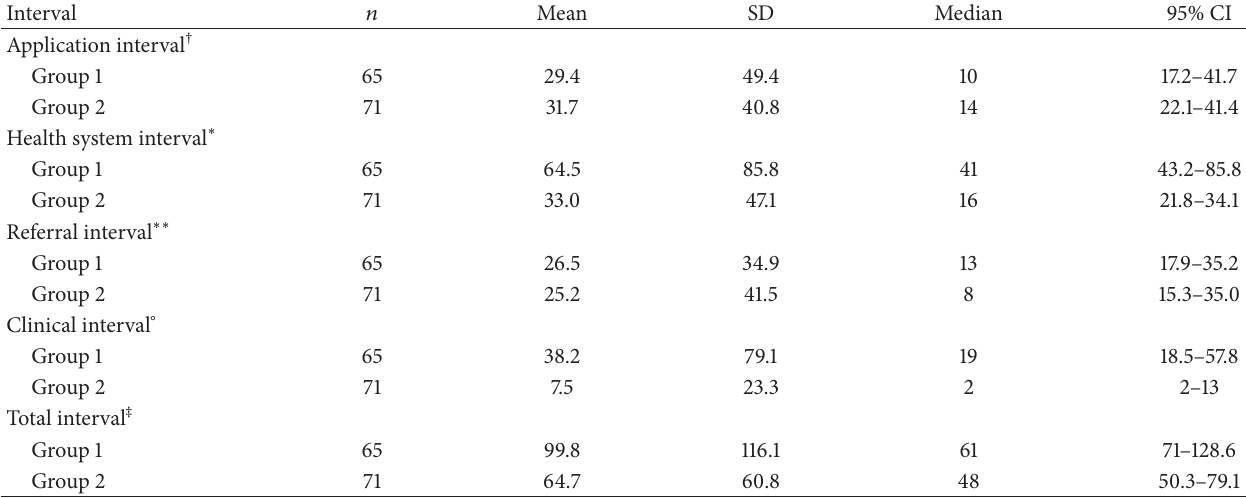
Table 2: The values associated with several intervals